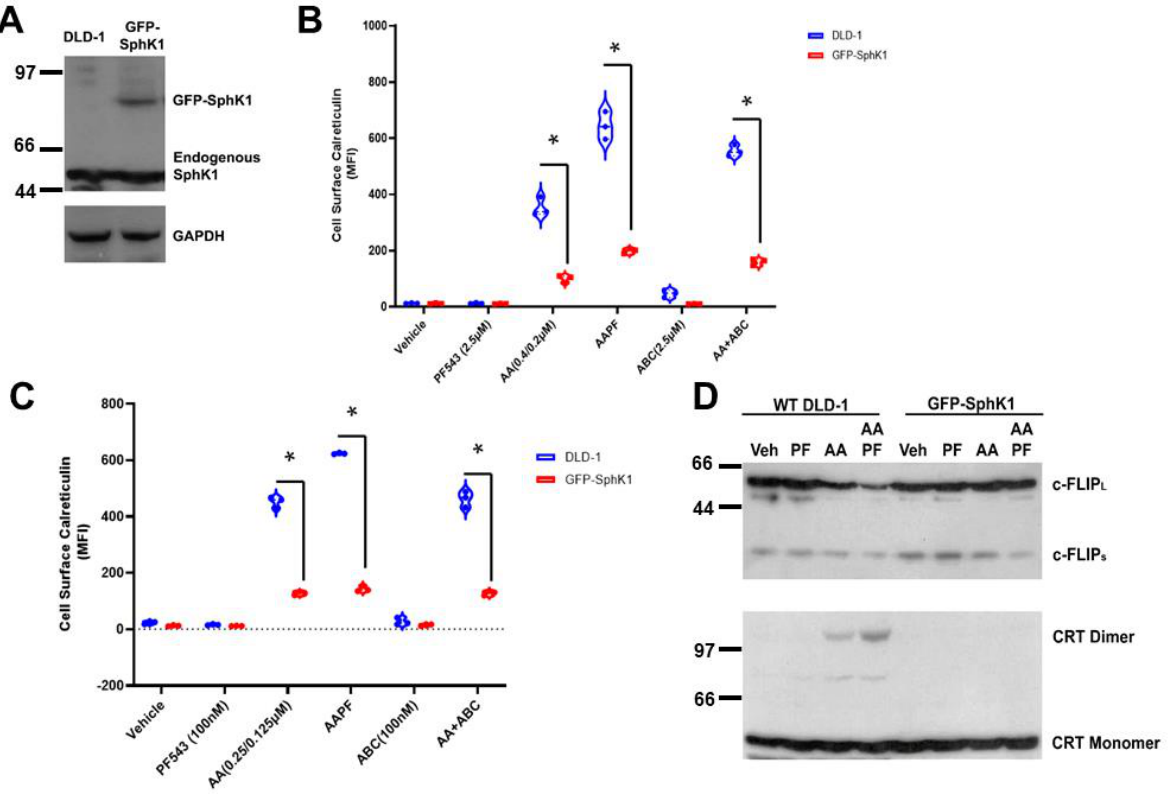
Figure 4. SphK1/S1P over-expression renders DLD-1 cells resistant to ABT/AZD induced ICD by stabilizing c-FLIP. ( A ). Western blot analysis of SphK1 expression using SphK1 Abs. GAPDH con- trol. ( B ). EctoCRT exposure (MFI) under 5% FBS conditions in DLD-1 and GFP-SphK1 cells treated 20 h. Statistical analysis was performed using two-way ANOVA. ( * p ≤ 0.05 ) Asterisks indicate sig- nificant changes as reported in results section. ( C ). EctoCRT exposure (MFI) under 5% dlFBS condi- tions in DLD-1 and GFP-SphK1 cells treated 20 h. Statistical analysis was performed using two-way